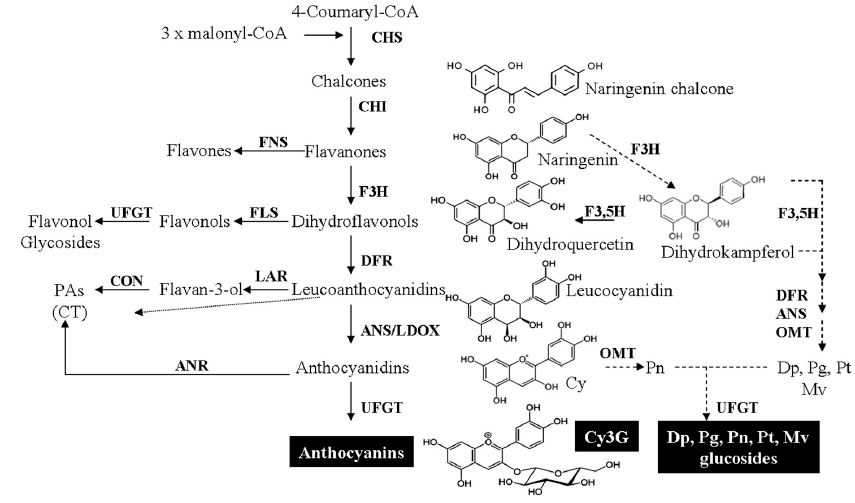
Figure 2. Anthocyanin biosynthesis. Cy3G main steps and crossroads. See abbreviations section for the meaning of each term.